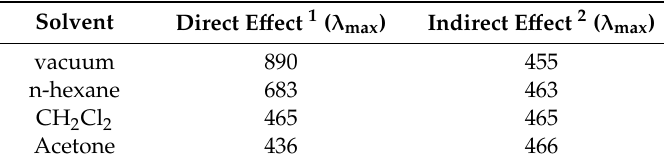
Table 4. Direct and indirect solvent e ff ects on the absorption maxima, λ max , of the CT band of viologen